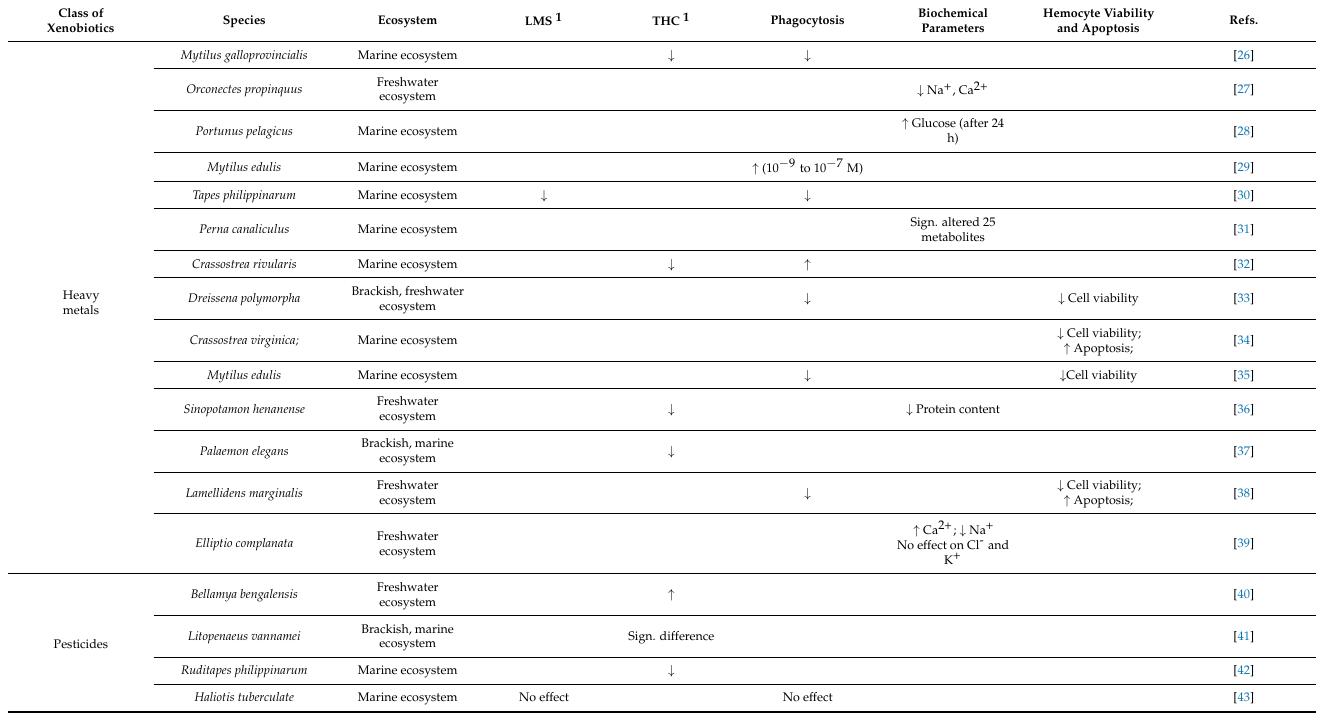
Table 2. The effects of different classes of xenobiotics on the hemocytes and hemolymph of several aquatic invertebrates. The symbol ↑ indicates an increase in value; the symbol ↓ indicates a decrease in